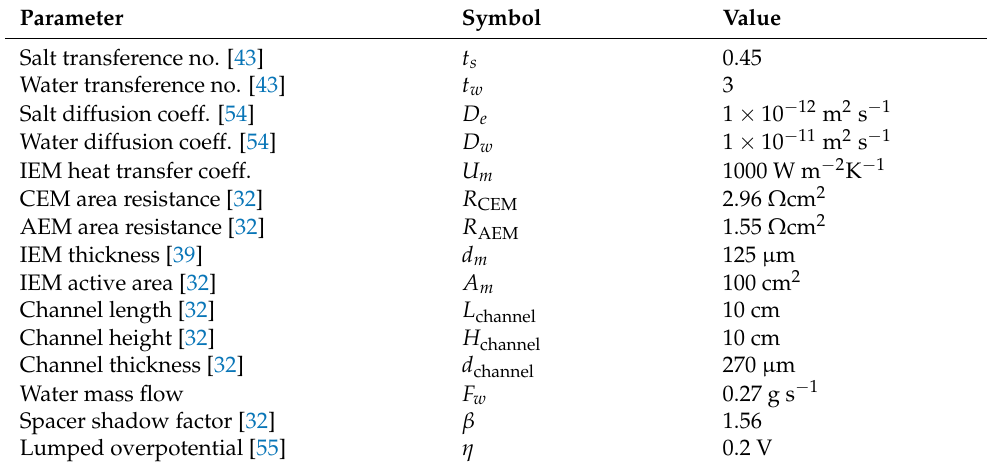
Table 1. System parameters used in the REDHE modelling. Parameter Symbol Value Salt transference no. [43] t s 0.45 Water transference no.